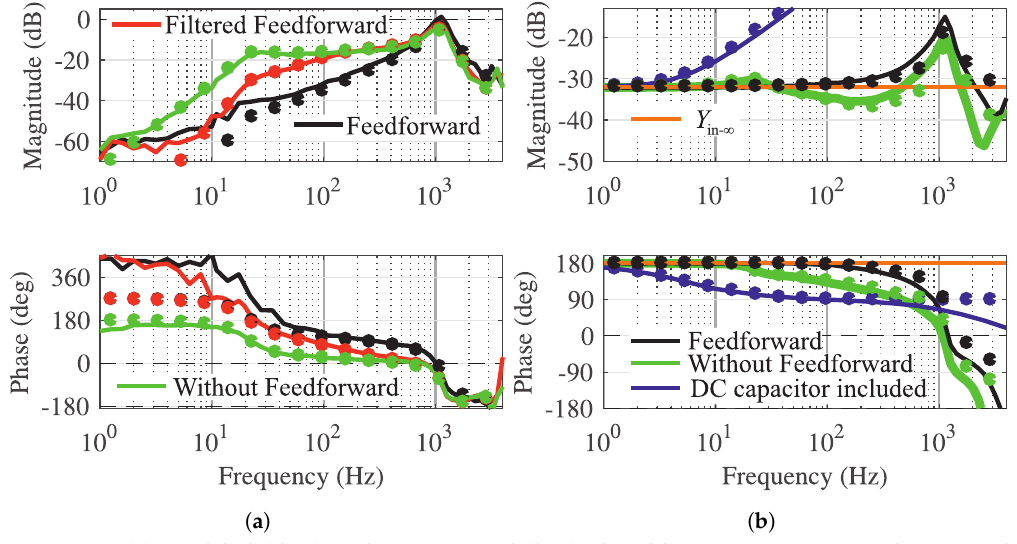
Figure 9. ( a ) Modeled (dots) and experimental (line) closed-loop input-to-output dynamics d component. ( b ) Modeled (dots) and experimental (line) closed-loop input